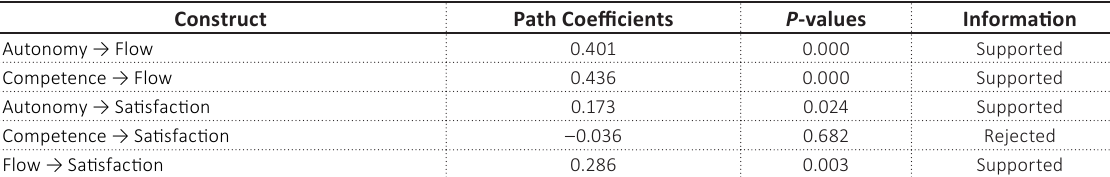
Table 7. Path coefficient and p-value of non-extreme adventure